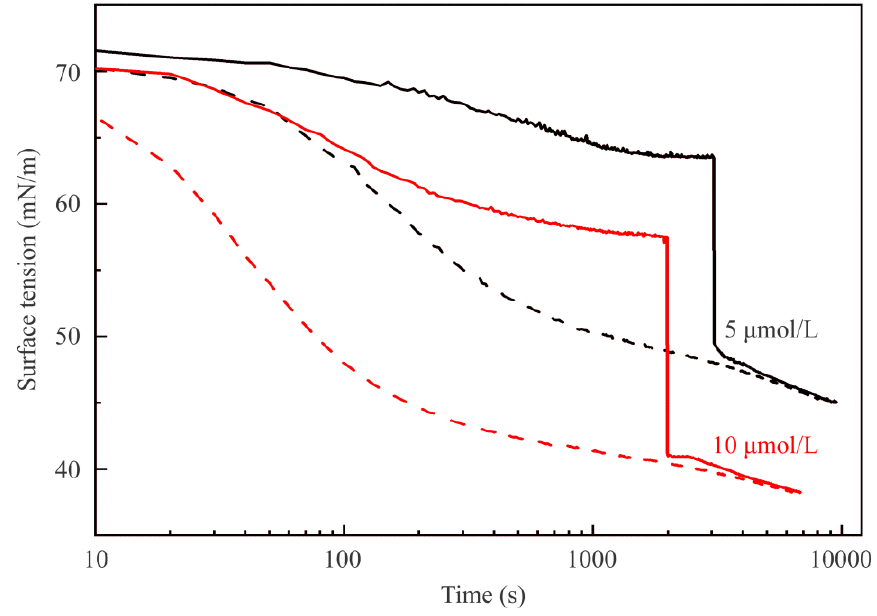
Figure 2. Dynamic surface tension of 5 μmol/L and 10 μmol/L C 13 DMPO solutions for drops formed in a cell initially containing only air and injection of 2 mL of hexane after equilibration (solid curves); dashed curves illustrate the dynamics of the same solutions for drops formed in a cell with pre-saturated hexane atmosphere.